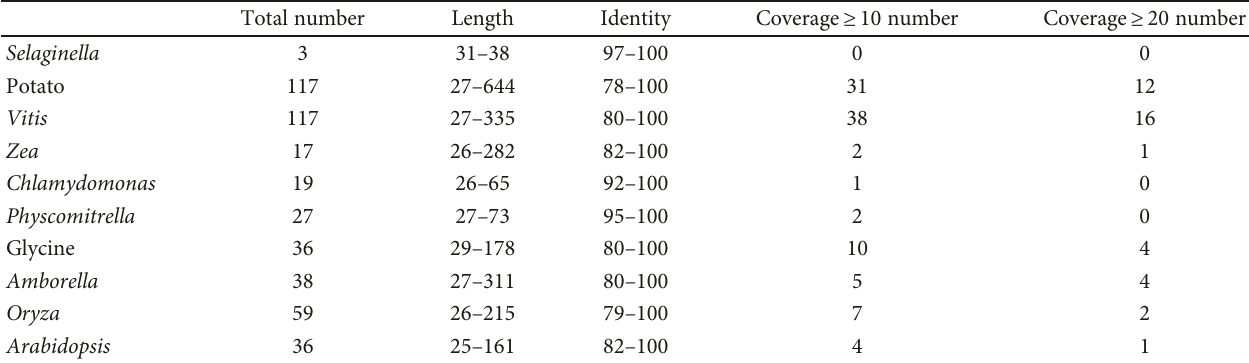
Table 1: Summary of the conserved lncRNAs.